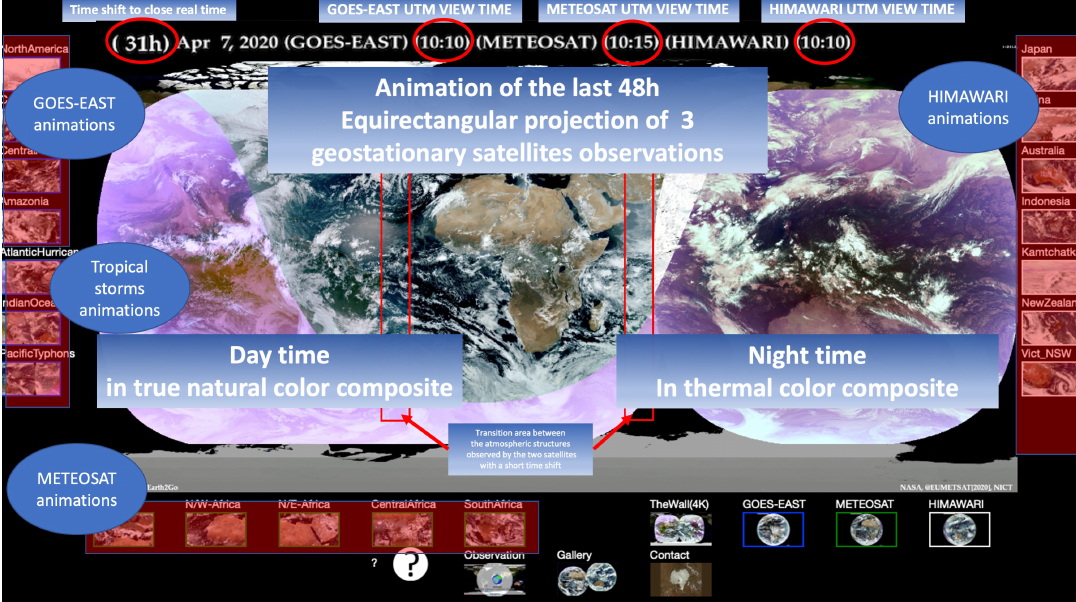
Figure 15. Snapshot of “The Wall” website at